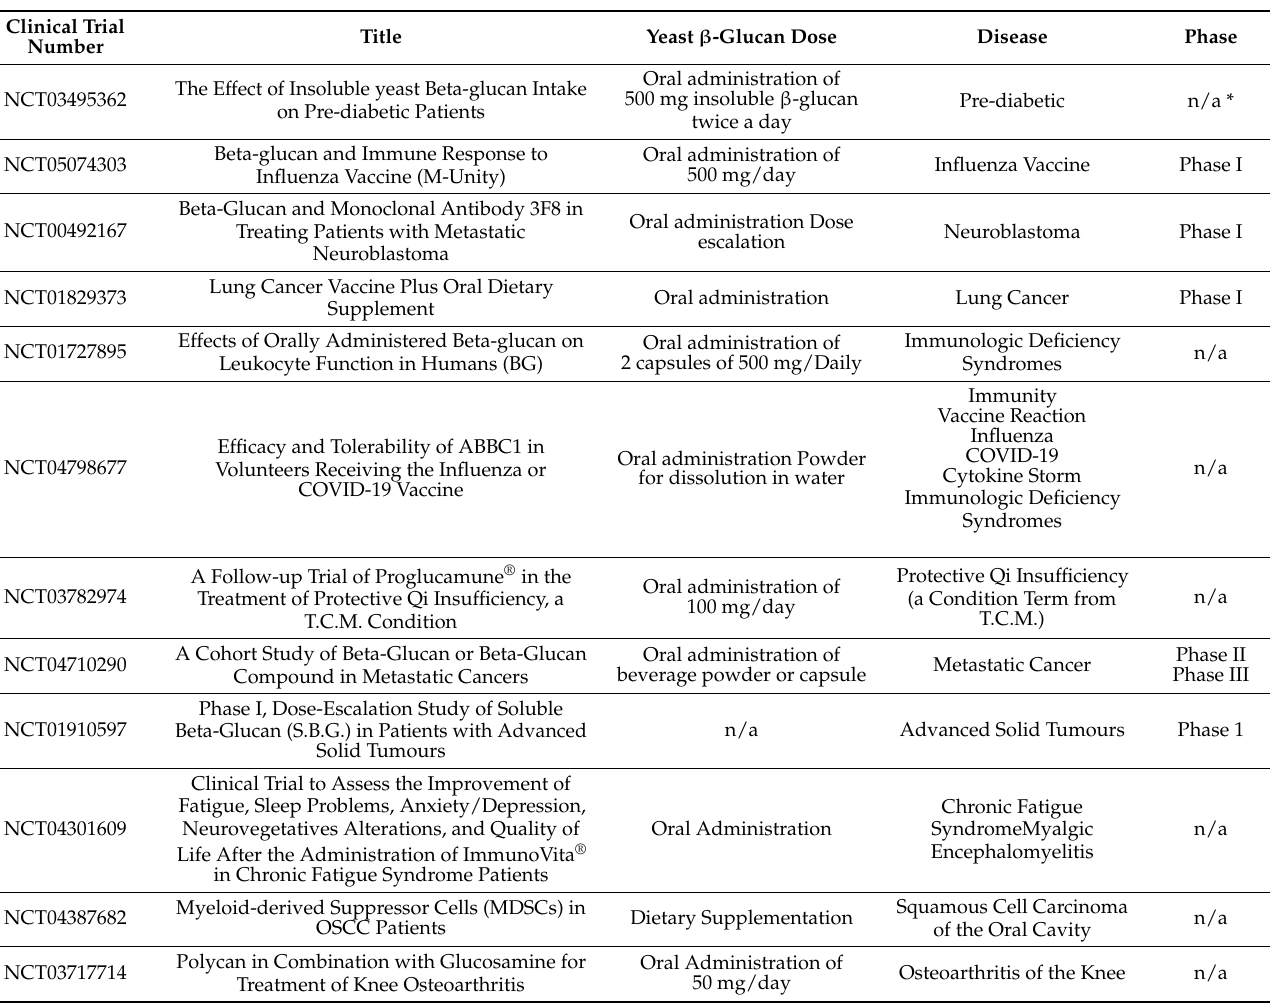
Table 1. Registered clinical trials on yeast β -glucan as a potential therapeutic agent. Information from clinicaltrials.gov (accessed on 28 March 2022). * n/a; information not